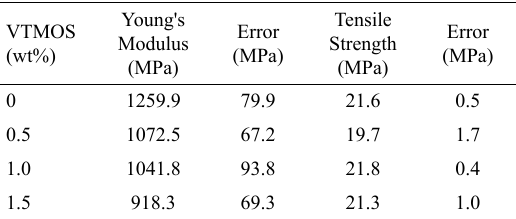
Table 5. Tensile mechanical properties of HMWPE and VTMOS crosslinked HMWPE